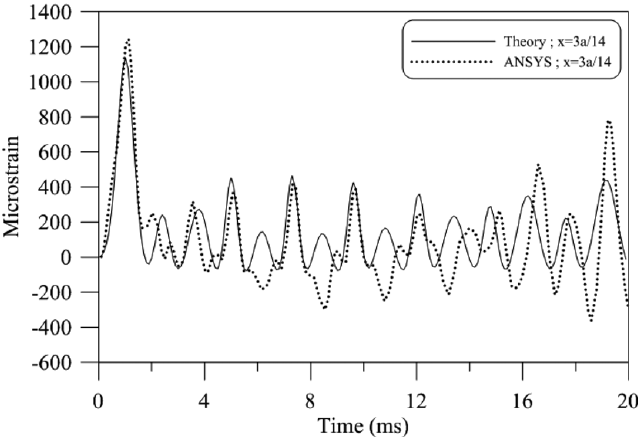
Fig. 14. The strain-time history ( ε xt − t ) at top surface of point (3a/14,